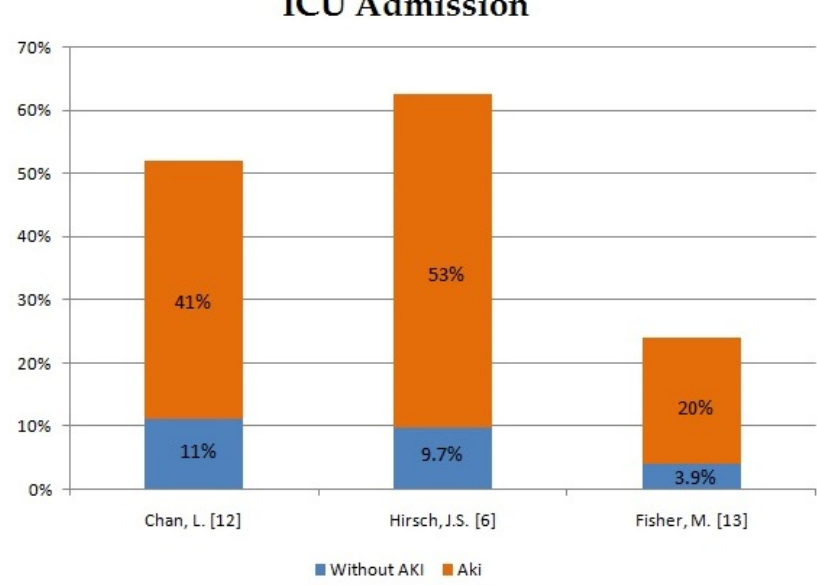
Figure 1. Intensive care unit admission in patients with AKI and no AKI [6,12,13].